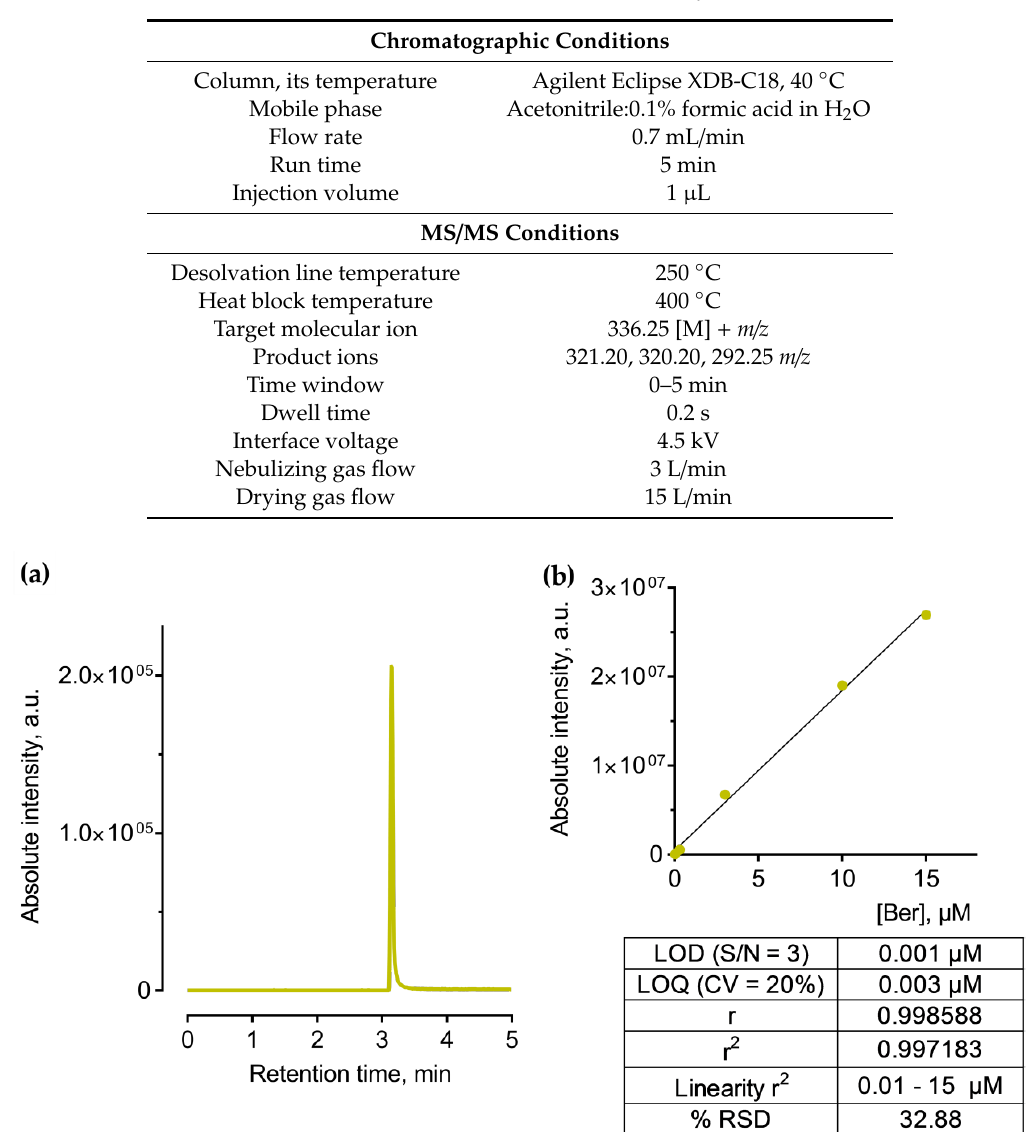
Table 1. HPLC-ESI-MS / MS conditions for analysis of Ber.